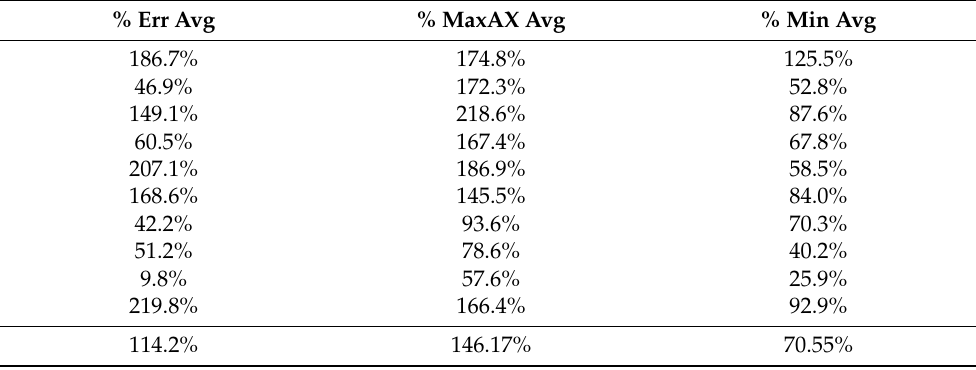
Table A25. Set 1, trials 11–20 data (single 0.5 PR value).